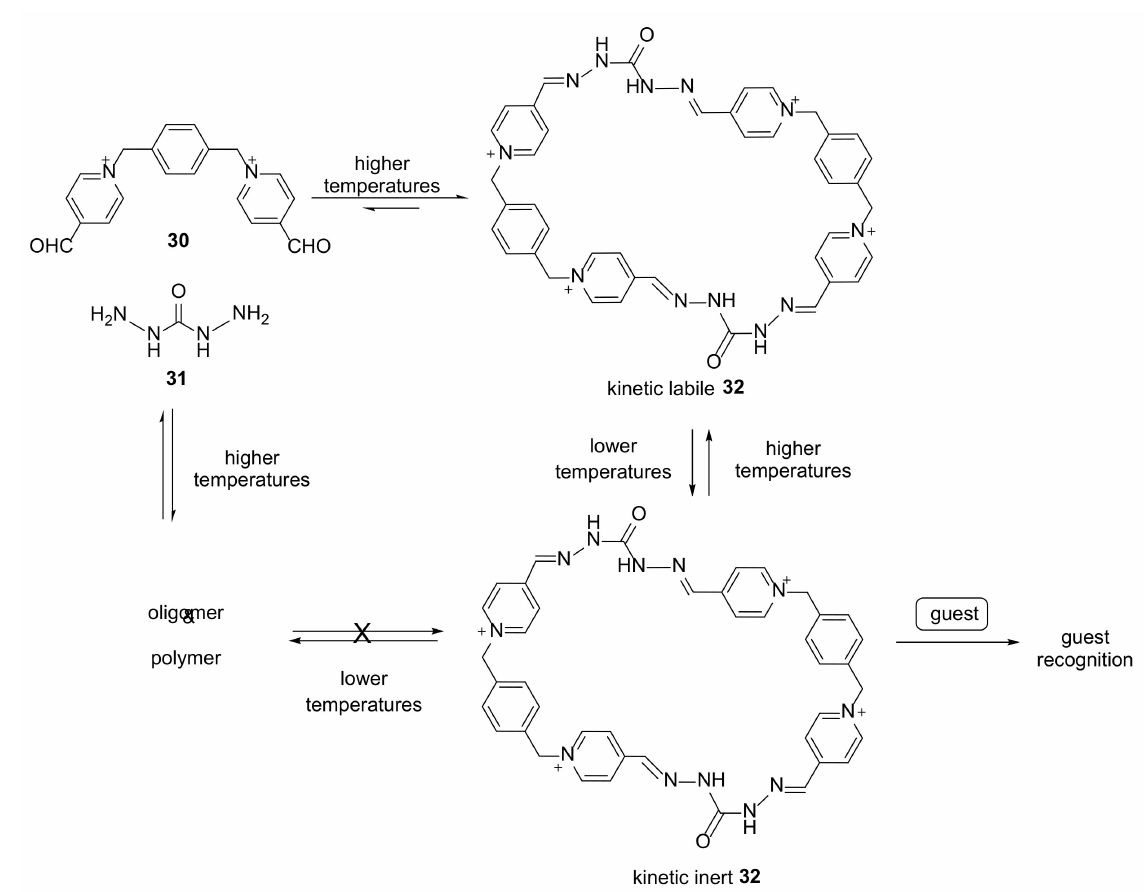
Figure 5. Selective and nonselective syntheses of hydrazone macrocycle 32